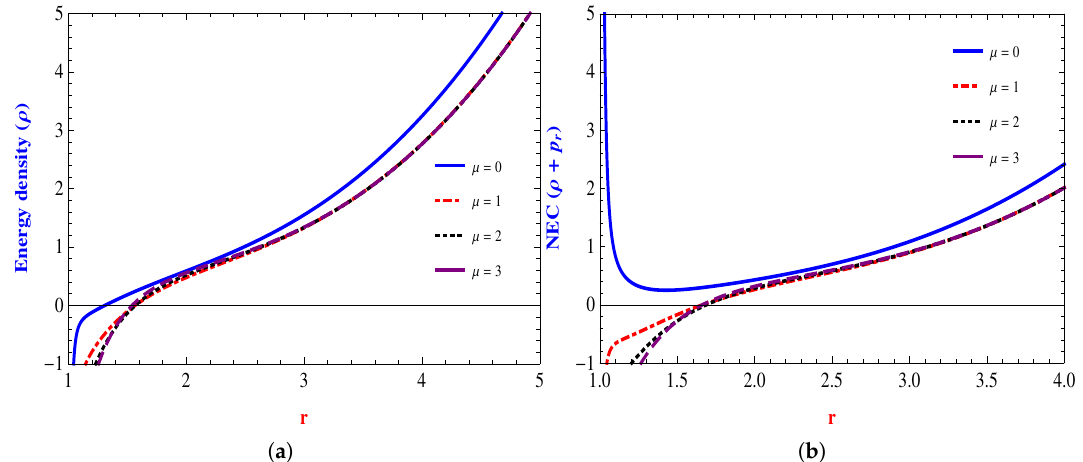
Figure 10. Plots: ( a ) Energy density ( ρ ) and ( b ) Radial NEC ( ρ + p r ) with throat radius r 0 = 1 and α = − 0.1 in f ( Q ) = Q + α gravity. Q